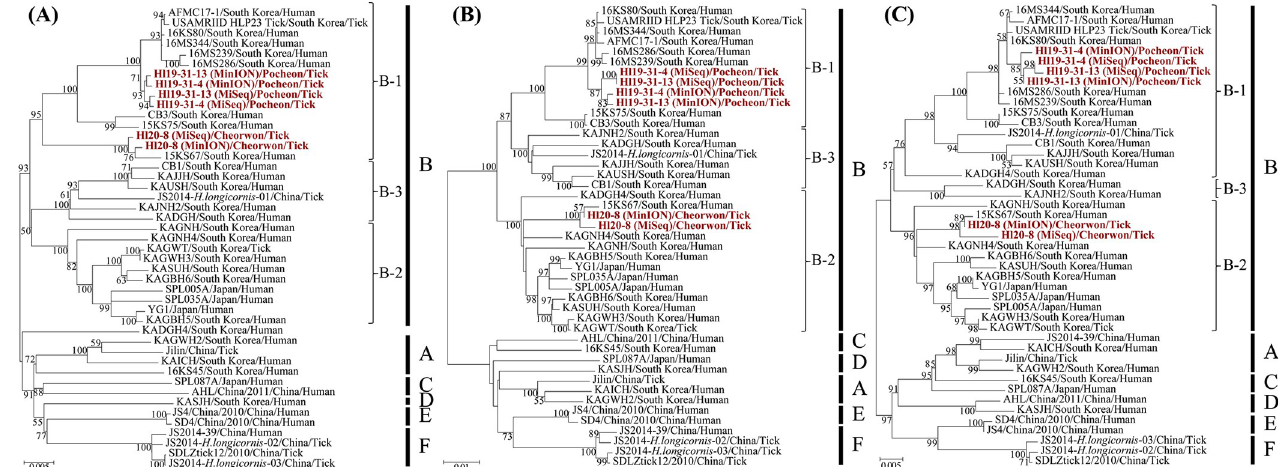
Fig 4. Phylogenetic analyses inferred to open reading frame (ORF) sequences of severe fever with thrombocytopenia syndrome virus (SFTSV) tripartite genomes. The phylogenetic trees were generated using maximum likelihood methods in MEGA7 with bootstrap 1,000 iterations based on the complete ORF regions of the SFTSV (A) L (17–6,270 nt), (B) M (19–3,240 nt), and (C) S (29–1,702 nt) segments. The scale bars indicate the number of nucleotide substitutions per site. The numbers at each node are bootstrap probabilities determined for 1,000 replicates. The SFTSV obtained in this study is shown in red lettering. The genetic clades indicate six genotypes (A-F) and three sub-genotypes (B-1 to B-3) in the right panel. The genomic sequences of SFTSV in this figure are described in S5 Table.